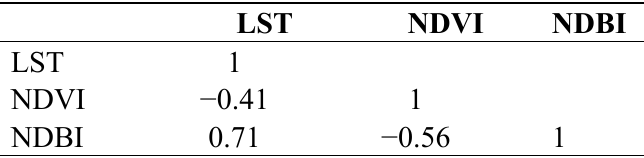
Table 7. The correlation